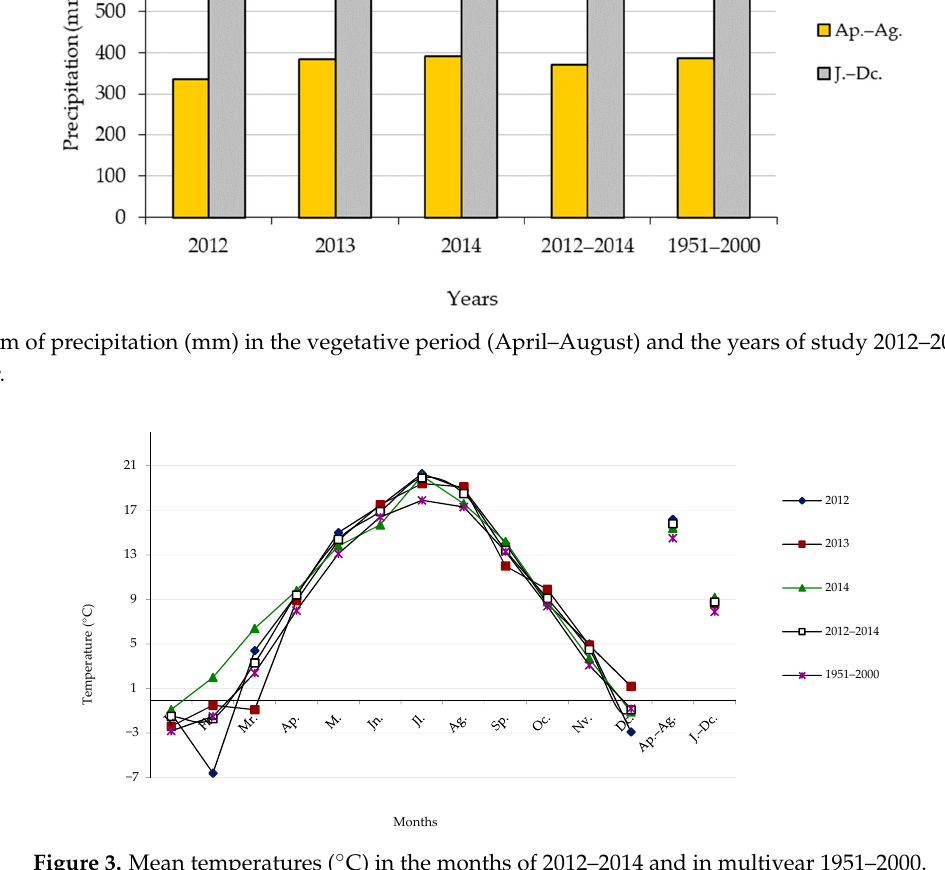
Figure 3. Mean temperatures (°C) in the months of 2012–2014 and in multiyear 1951–2000.